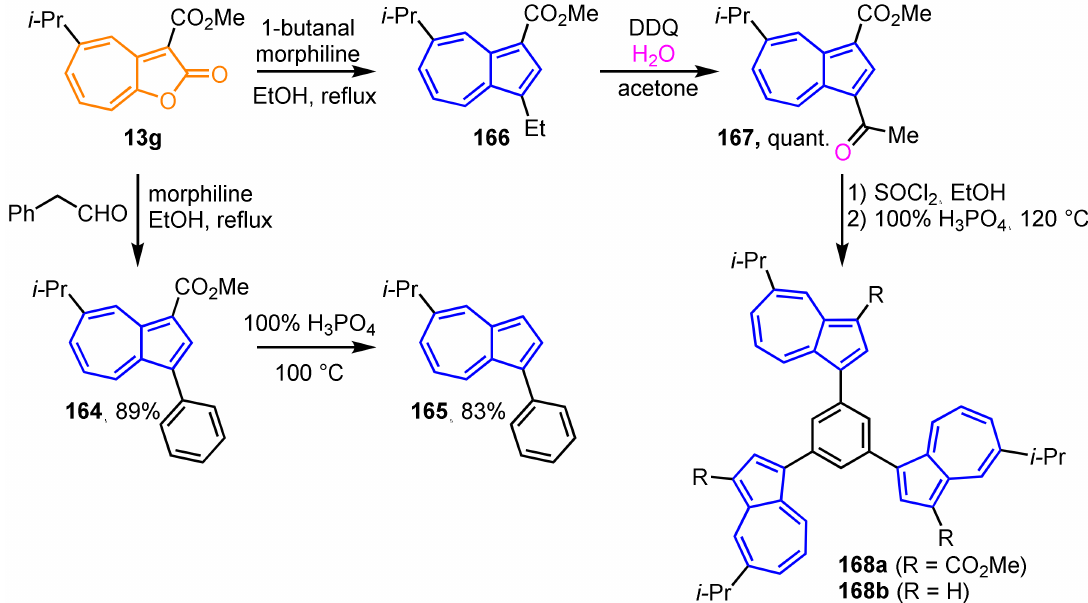
Scheme 40. Synthesis of 1-phenylazulenes 164 and 165 , and 1,3,5-tri(1-azulenyl)benzenes 168a and 168b via the reaction of 2 H -cyclohepta[ b ]furan-2-one 13g with in situ generated